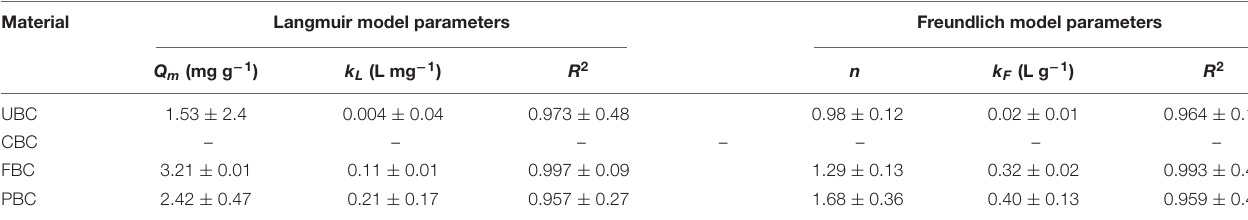
TABLE 4 | Langmuir and Freundlich model parameters (mean ± standard deviation, n = 3) for untreated biochar (UBC), CaO-impregnated biochar (CBC), FeCl 3 -impregnated biochar, and untreated biochar mixed with Polonite R (cid:13) (PBC).